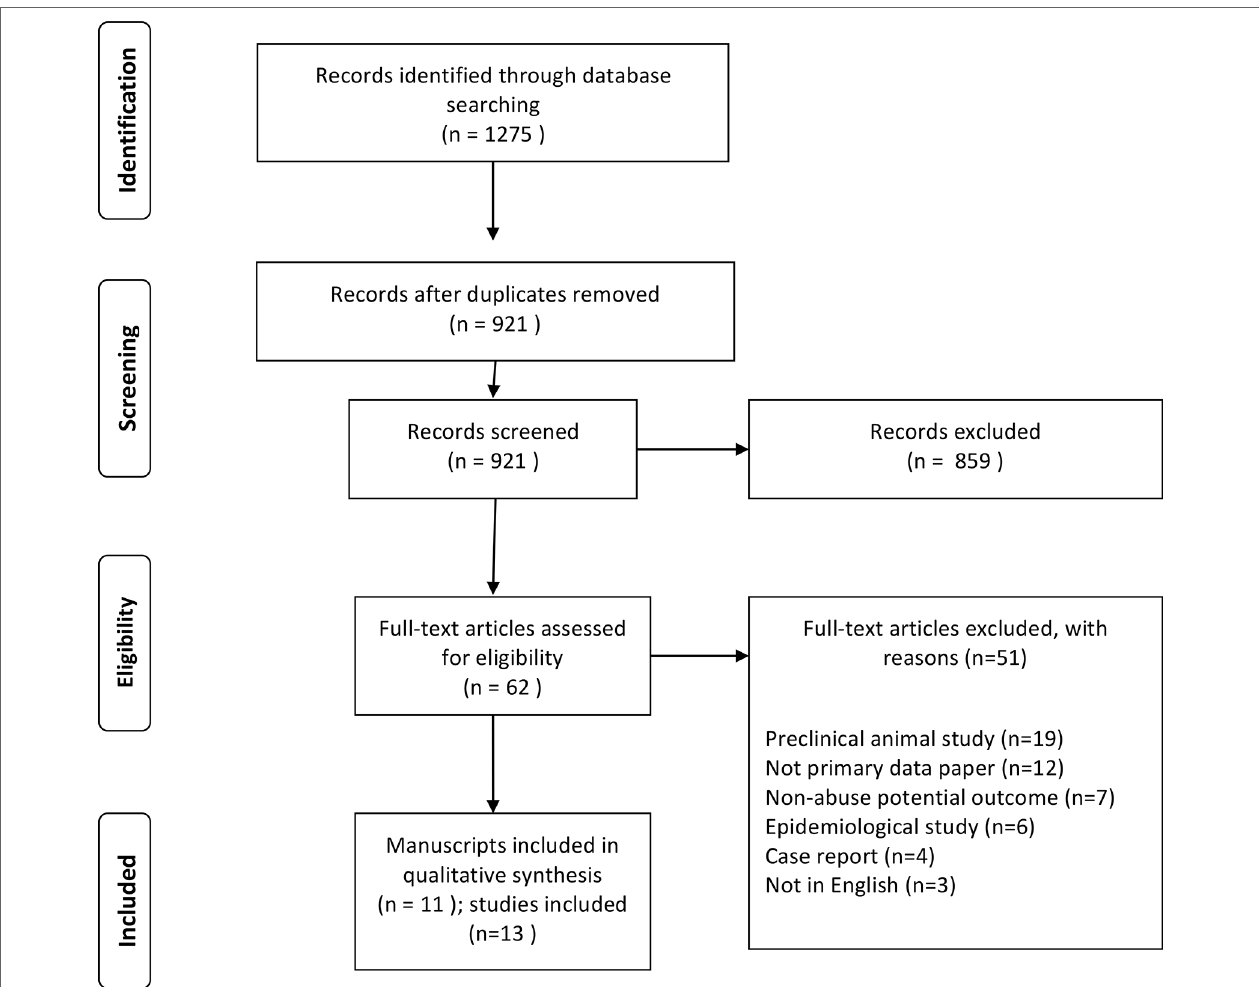
FIGURE 1 | PRISMA